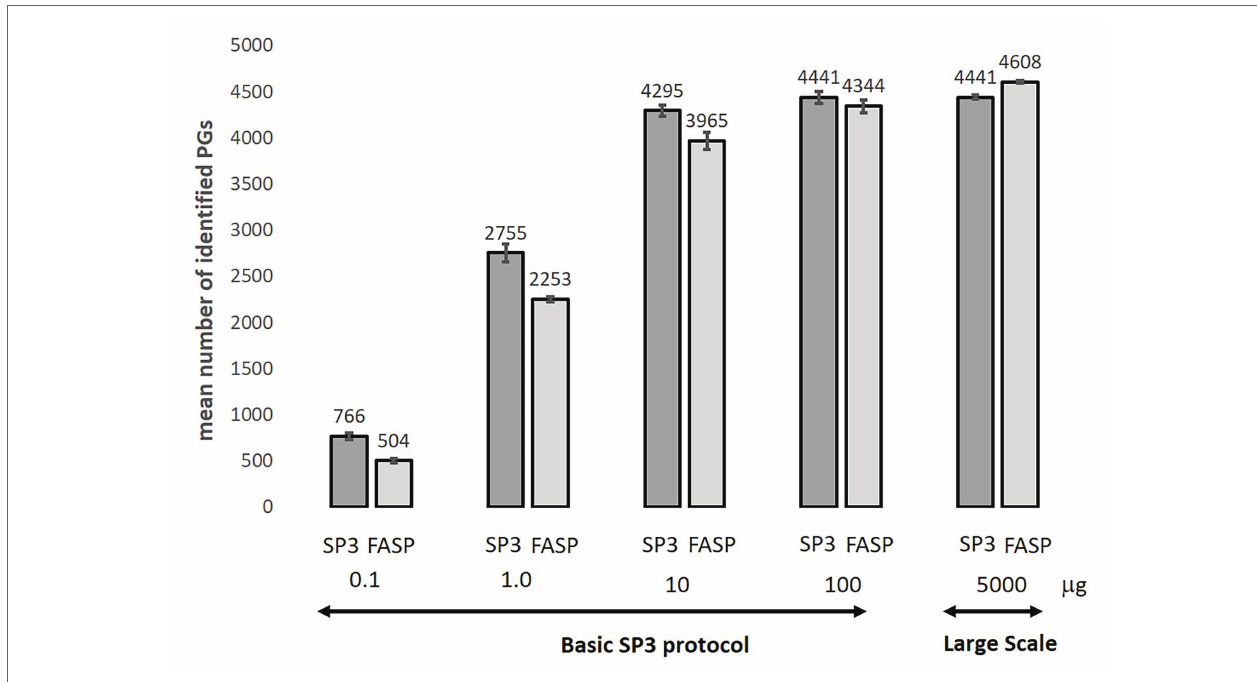
FIGURE 5 | Comparison of mean number of identified protein groups for SP3 and FASP methods over-tested protein load range. Standard deviation was applied for error bars calculation. Data were calculated as the average value from 3 or 5 (100 μ g) replicates. The only half of the final digested sample was injected for 0.1–1 μ g input amounts to prevent loss of sample from technical issues. In case of higher sample loads ( ≥ 10 μ g), we injected about 2 μ g of tryptic peptide